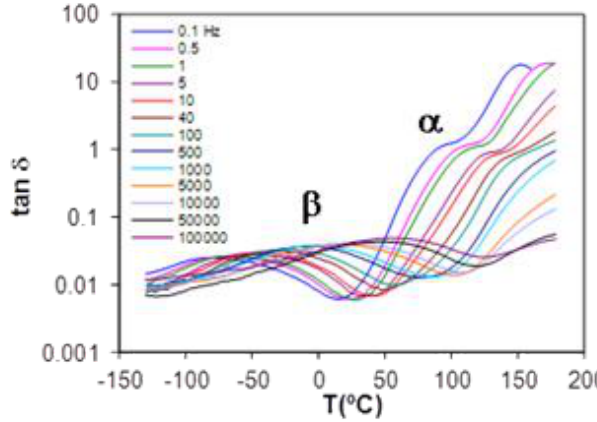
Figure 16. Dielectric spectrum of the cured ELP system at 2 K/min. Materials 2016 , 9 , 192